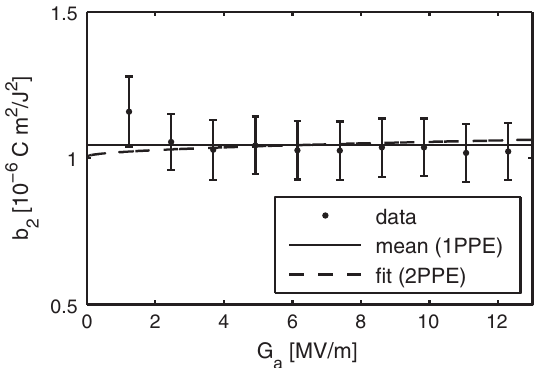
FIG. 4. First-order coefficient b 1 as a function of acceleration field G . a